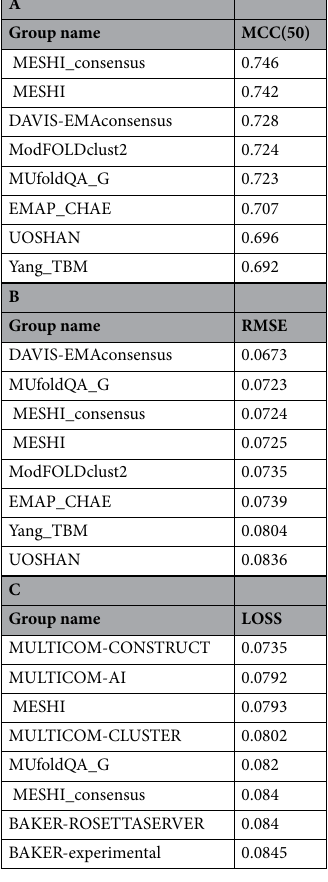
Table 1. CASP14 performances. The tables present the top-scoring groups 31,71–75 by three measures: MCC(50) (A), RMSE (B), and LOSS (C). Results are reproduced from the CASP website at (https:// predi ction center. org/ casp14). Note that in the CASP site RMSE and LOSS are referred to as ”differences (predicted vs observed)” and ”difference from the best”, respectively, and their performances are depicted as percentages. The servers ”Seder2020” and ”Seder2020hard” that submitted an EMA prediction for a single target were